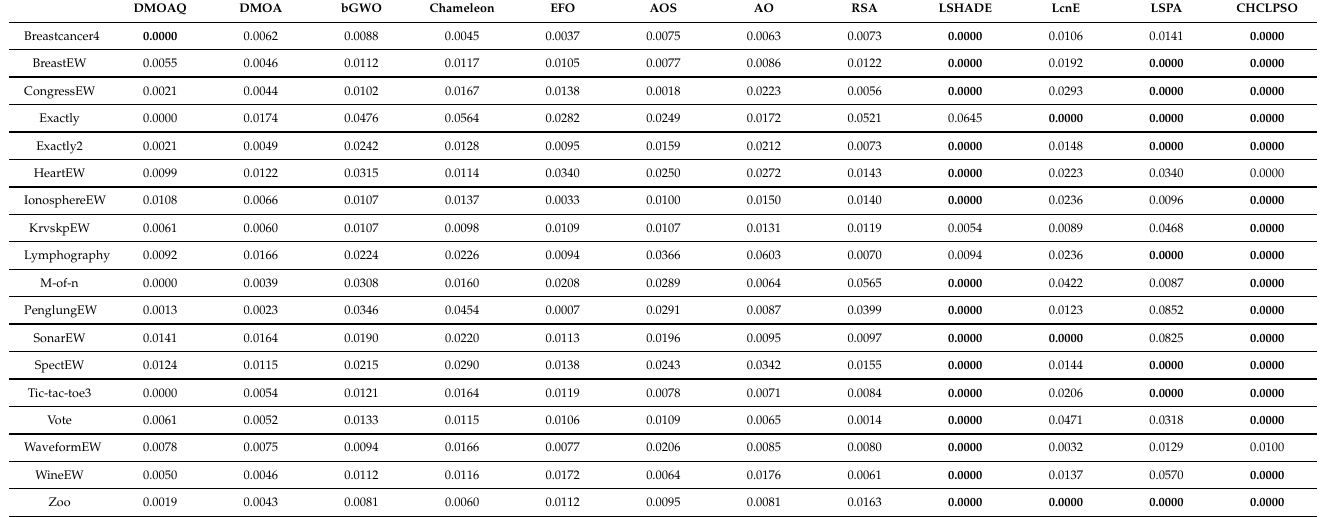
Table 4. Standard deviation of the fitness function